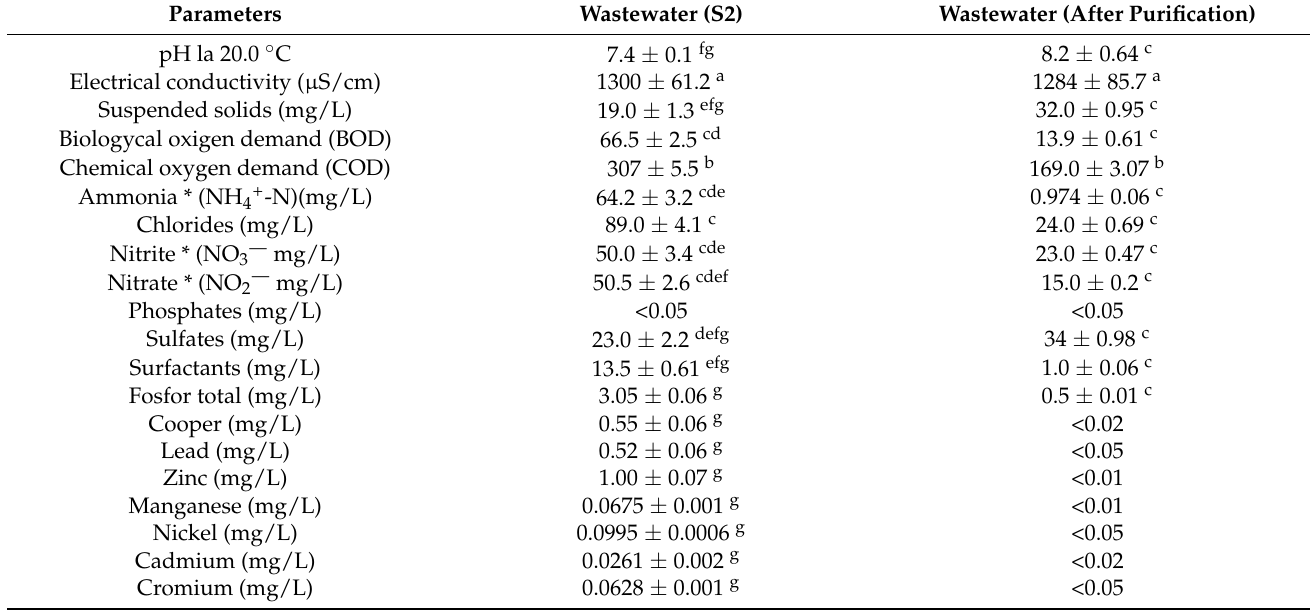
Table 3. The chemical composition of wastewater before and after purification on zeolite support. (Data represent the mean ± standard deviation; n = 3 parallel